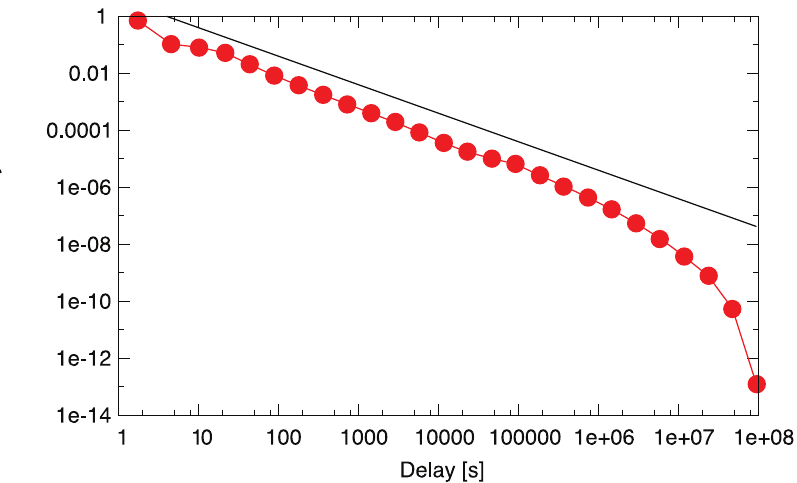
Figure 8. Distribution of time delay between transactions initiated from a single Bitcoin address. We observe a power-law distribution close to the widely observed P ( T ) * T { 1 , the exponential cutoff corresponds to the finite lifetime of the Bitcoin system.